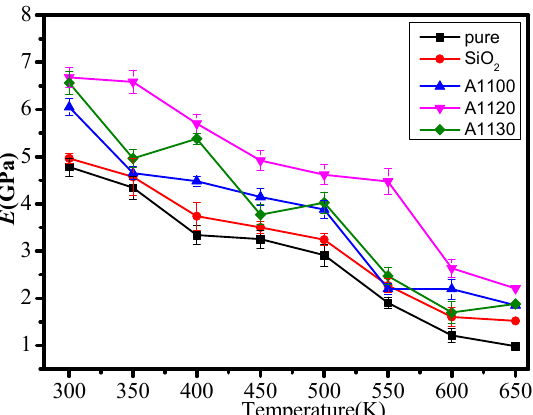
Figure 4. Elastic modulus of five models at different temperatures.